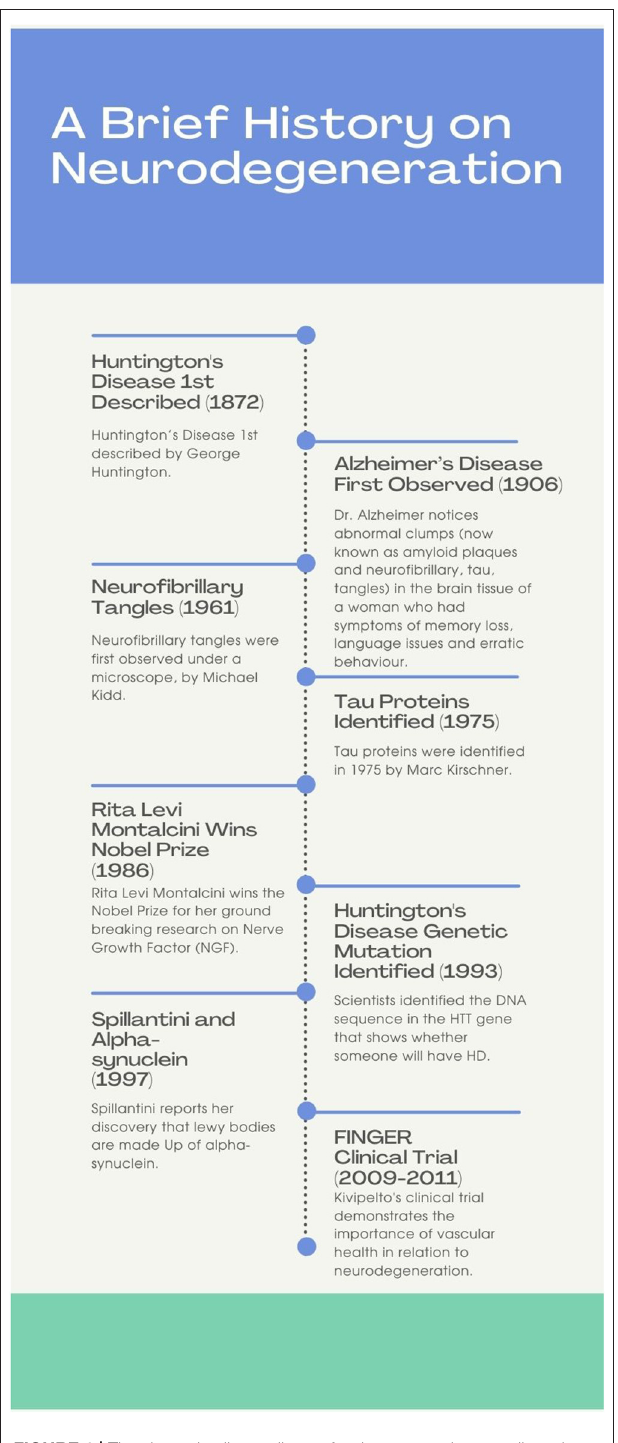
FIGURE 1 | The above timeline outlines a few key events that contributed to knowledge of neurodegeneration. Some of the events shown are the first descriptions of neurodegenerative diseases, others are key discoveries regarding the mechanisms of neurodegeneration, one is a clinical